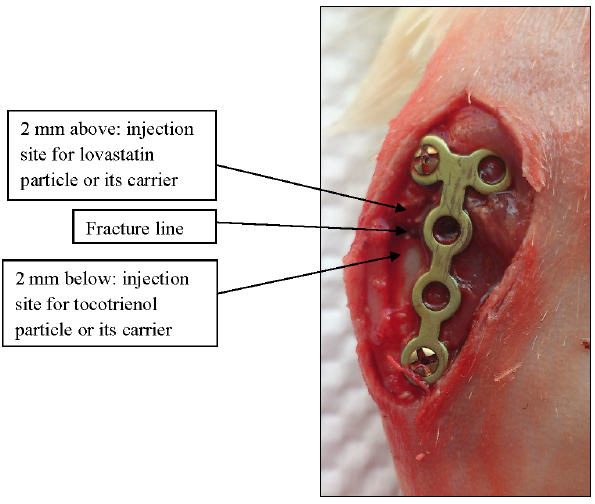
Fig. 1. Specific sites of injection for lovastatin and tocotrienol particles. Injection sites were made at 2 mm above the fracture line and 2 mm below the fracture line for lovastatin and tocotrienol particles